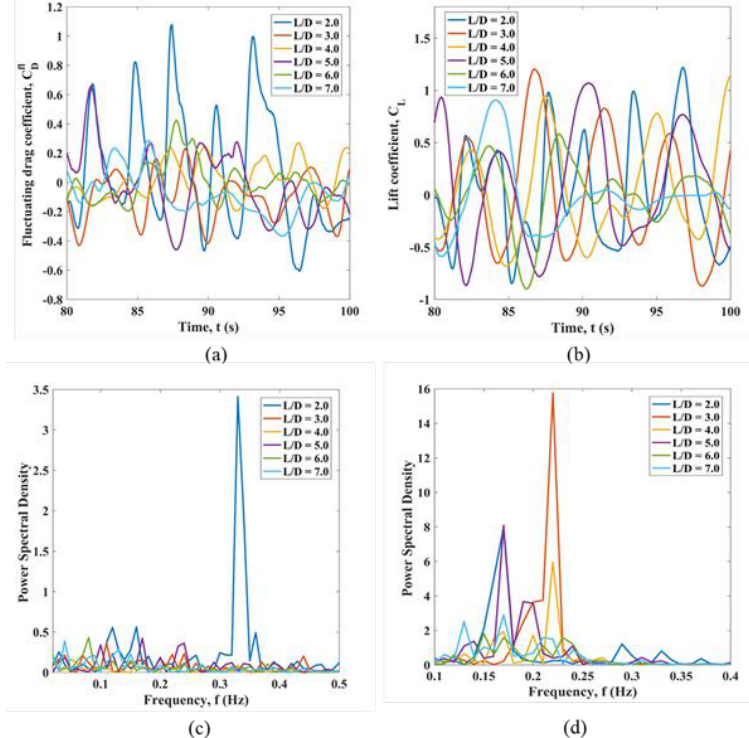
Figure A5. Fluid force coefficients for cylinder 6 immersed in the uniform flow: ( a ) time history of the fluctuating drag coefficient; ( b ) time history of the lift coefficient; ( c ) the drag coefficient FFT; ( d ) the lift coefficient FFT.